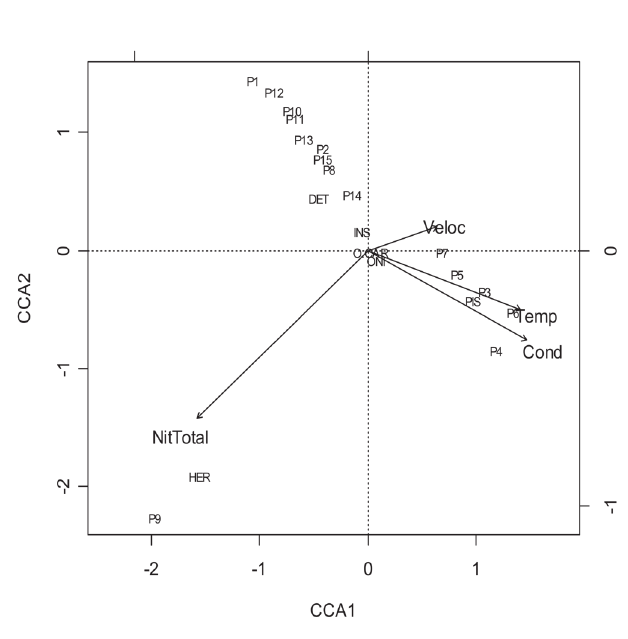
Fig. 4. Canonical Correspondence Analysis (CCA) showing the relationship between the biomass of insectivores (INS), omnivores (ONI), herbivores (HER), detritivores (DET), piscivores (PIS), omnivores-carnivores (O.CAR) and selected environmental variables. Temp = temperature; Veloc = Water Velocity; T.Nit = total nitrogen, Cond=